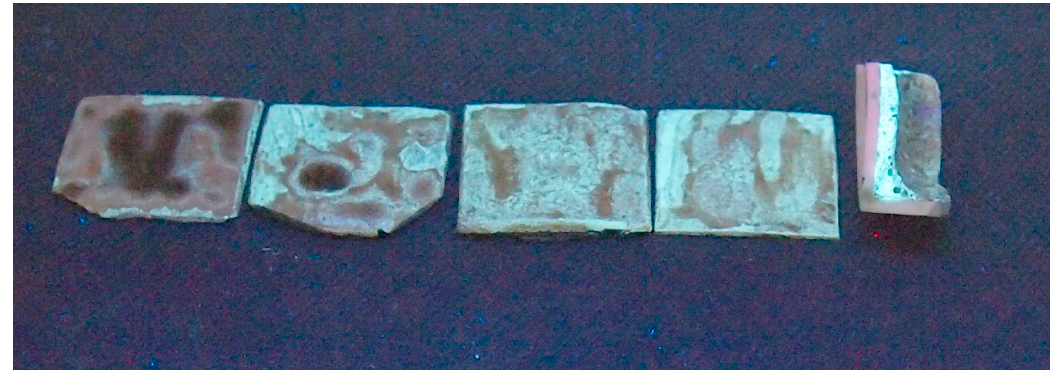
Figure 8. From the left: Coatings after CMAS interaction for 1, 4, 8 and 10 h and the cross-sectioned bottom of a crucible with sintered mixture of powders, respectively. Samples illuminated by the 312 nm lamp (i.e., 3.97 eV).